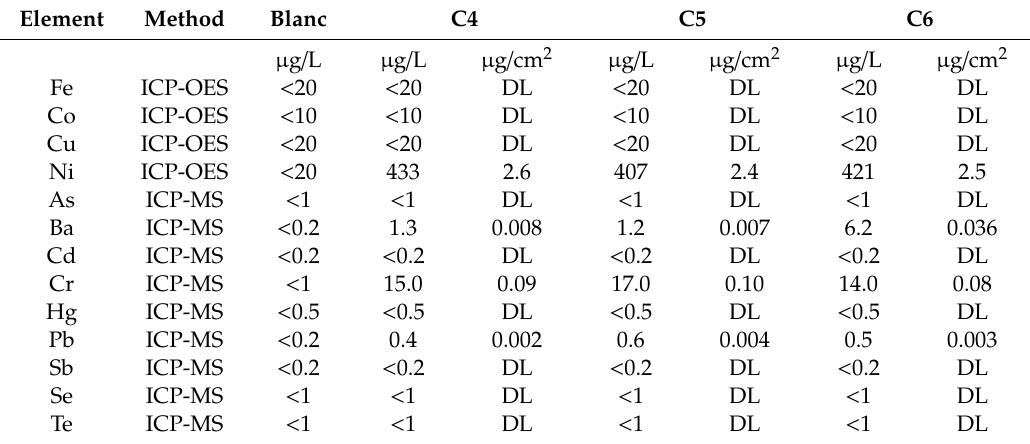
Table 6. ICP analysis of extraction results in the HCl 0.07 M solution. DL: Detection limit.